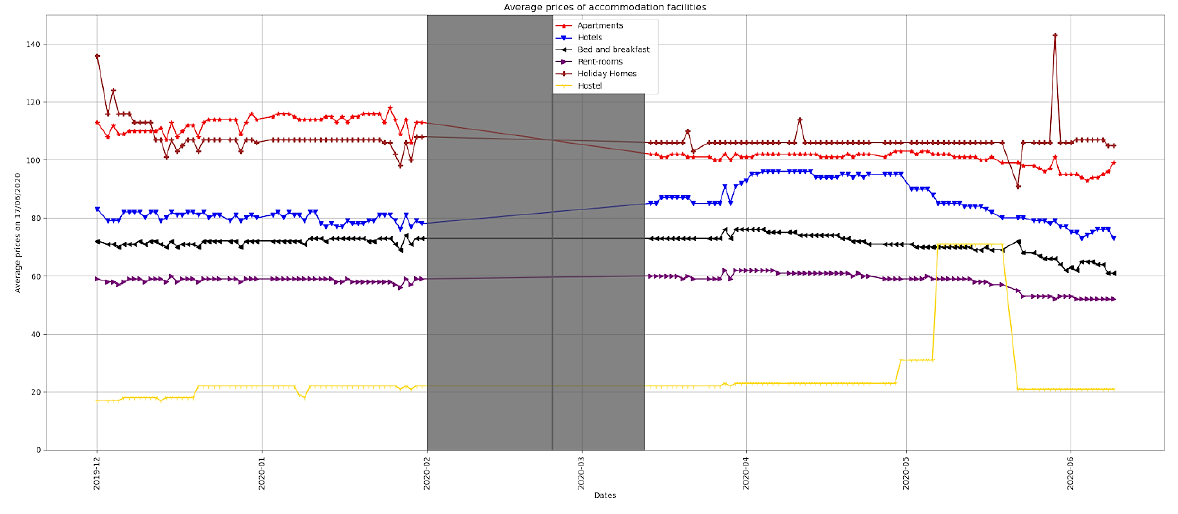
Figure 6. Average prices of accommodation facilities